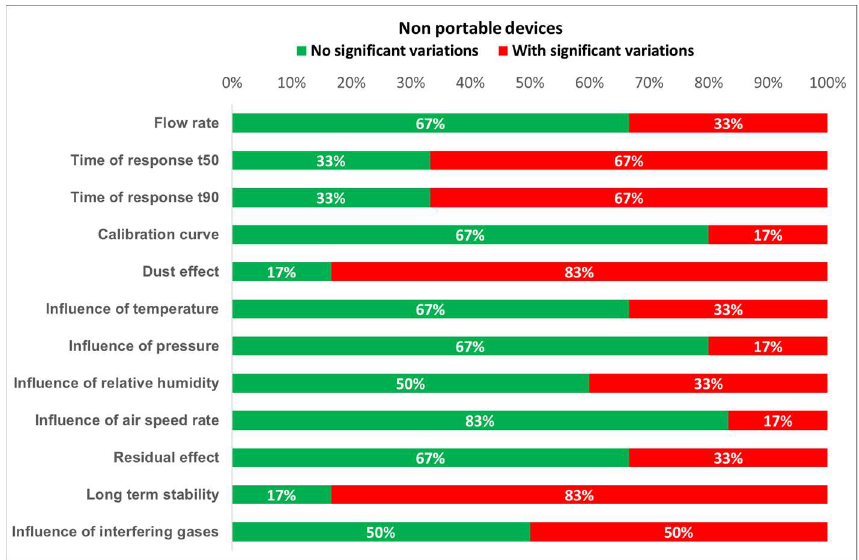
Figure 16. Detected variations for non-portable devices.